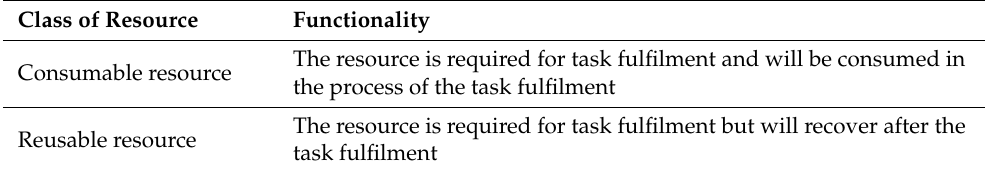
Table 4. Classes of basic